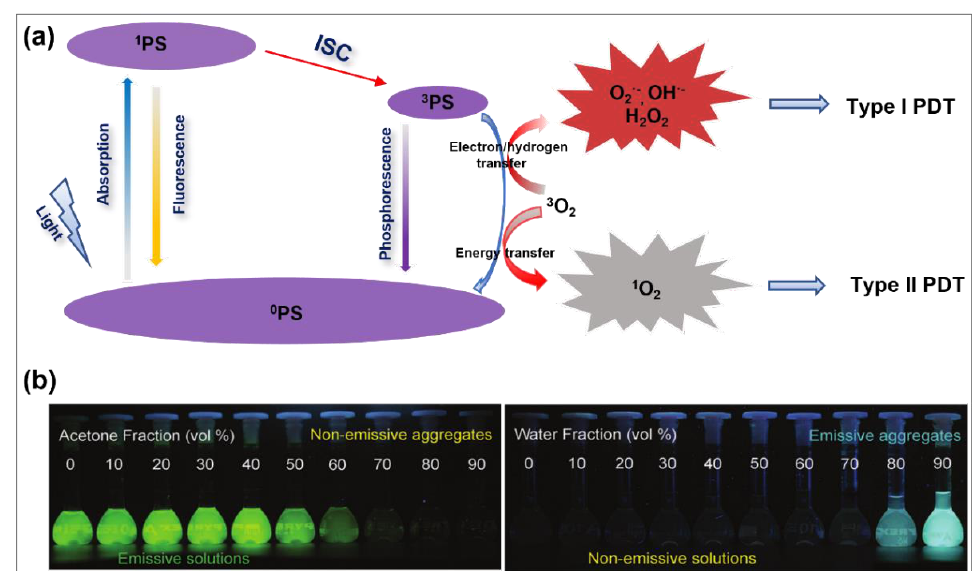
Figure 1. ( a ) Schematic of a Jablonski diagram showing ROS generation processes for organic PSs. ( b ) Comparison of fluorescence changes of ACQ (fluorescein isothiocyanate, FITC ) and AIE (tetraphenylethylene, TPE ) molecules in acetone (good solvent) and water (poor solvent) mixtures with different water fractions. Reprinted with permission from [39].